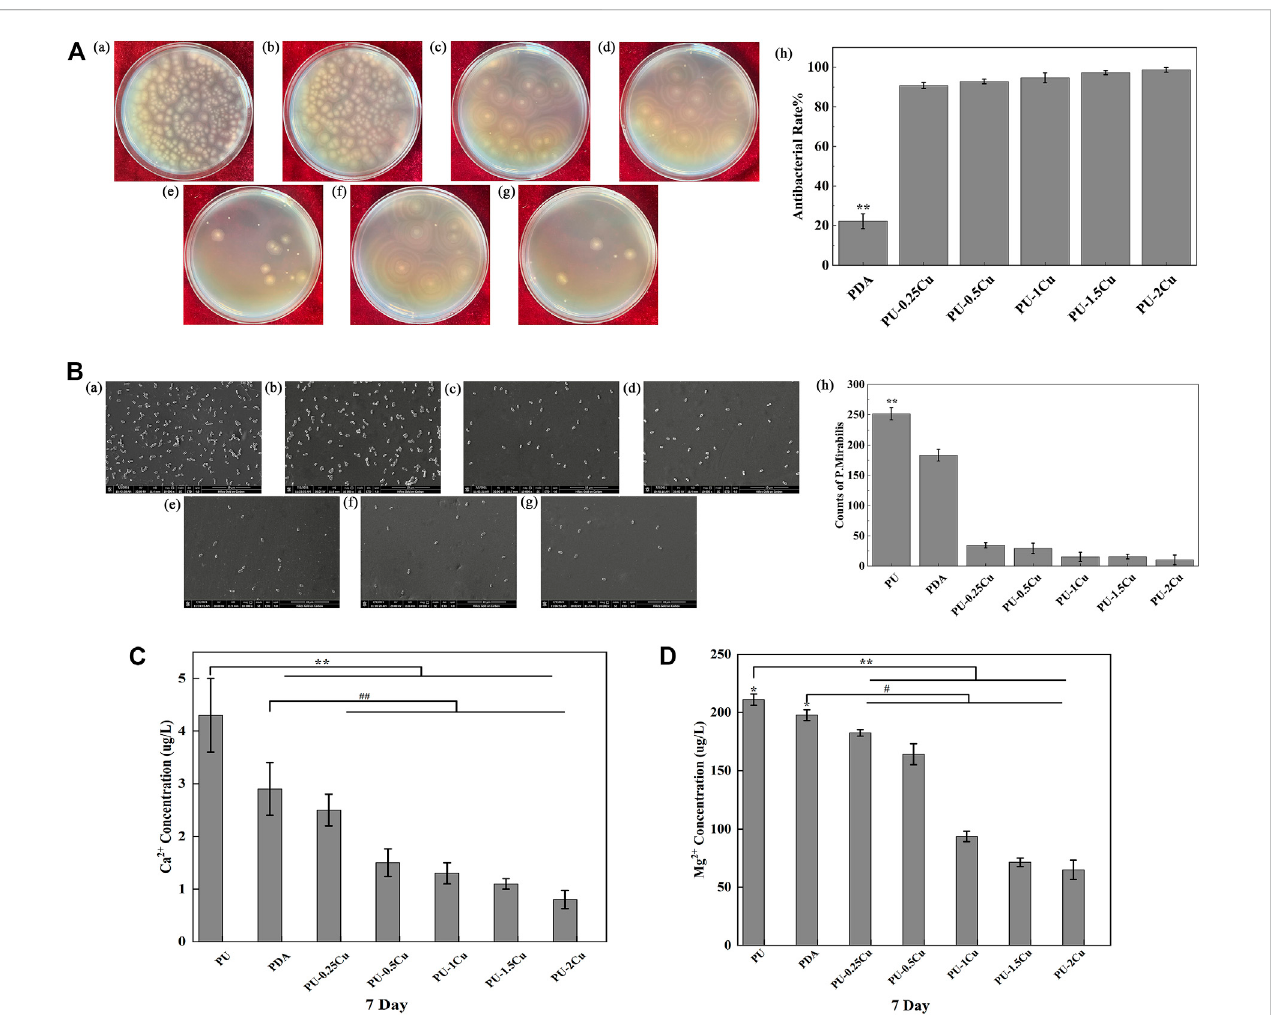
FIGURE 2 (A) (a) – (g) P.mirabilis